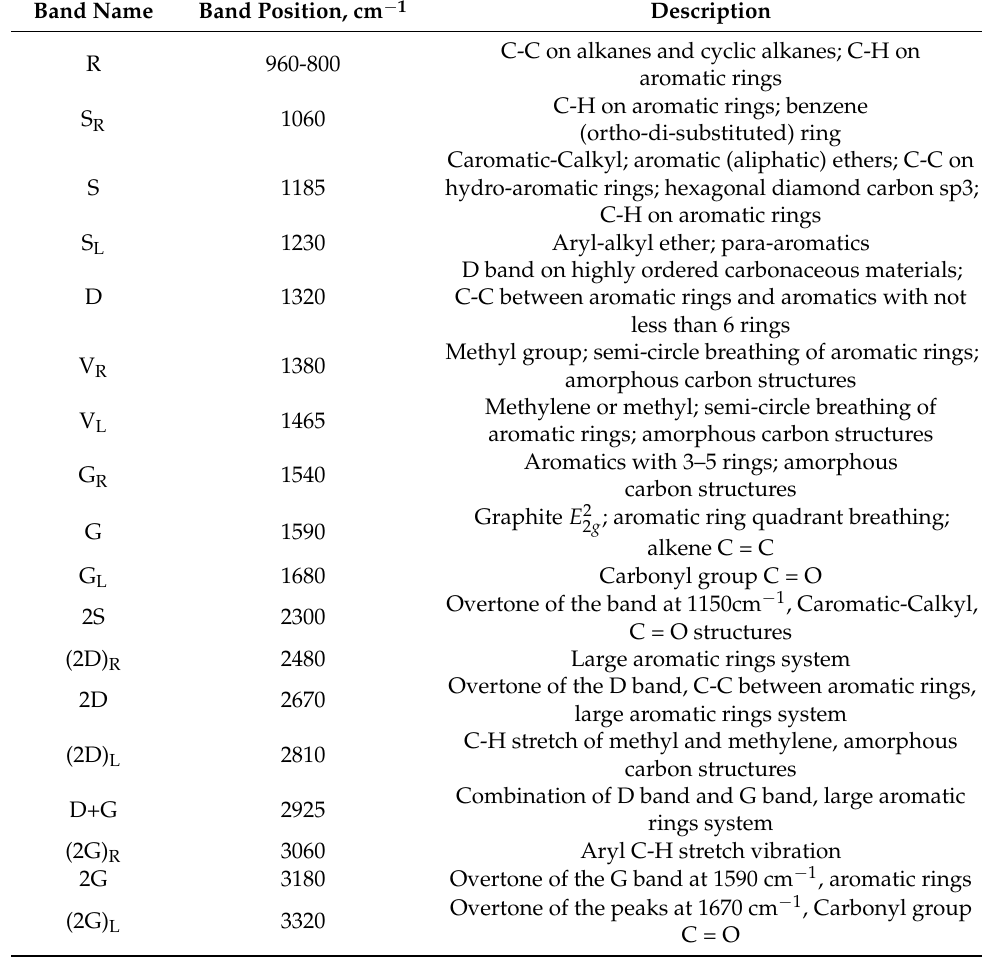
Table 1. A summary of the bands’ assignment